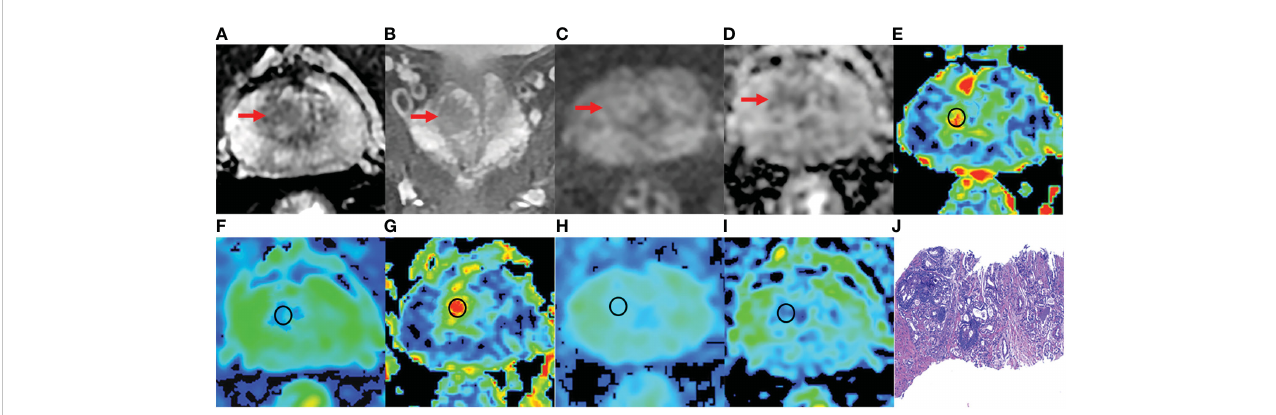
FIGURE 4 A 76-year-old man with BPH and PSA of 4.48 ng/ml. (A-D) The lesion with PI-RADS 3 seen in the right middle transition zone. (E) Fractional anisotropy (FA) of 0.201. (F) Mean diffusion (MD) of 1.214×10 -3 mm 2 /s. (G) Mean kurtosis (MK) of 0.512. (H) Diffusion coef fi cient (D) of 0.795×10 -3 mm 2 /s. (I) Distribute